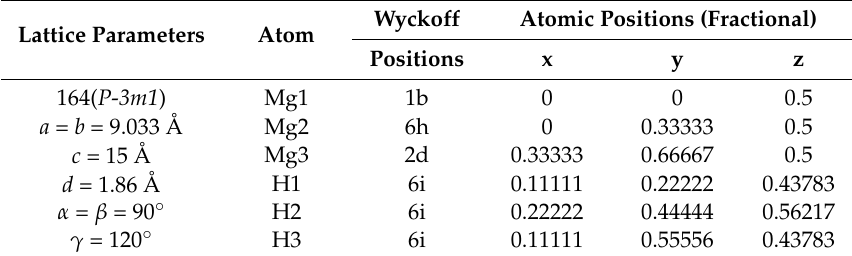
Table 1. The relaxed structural parameters and atomic positions of Mg 9 H 18 .